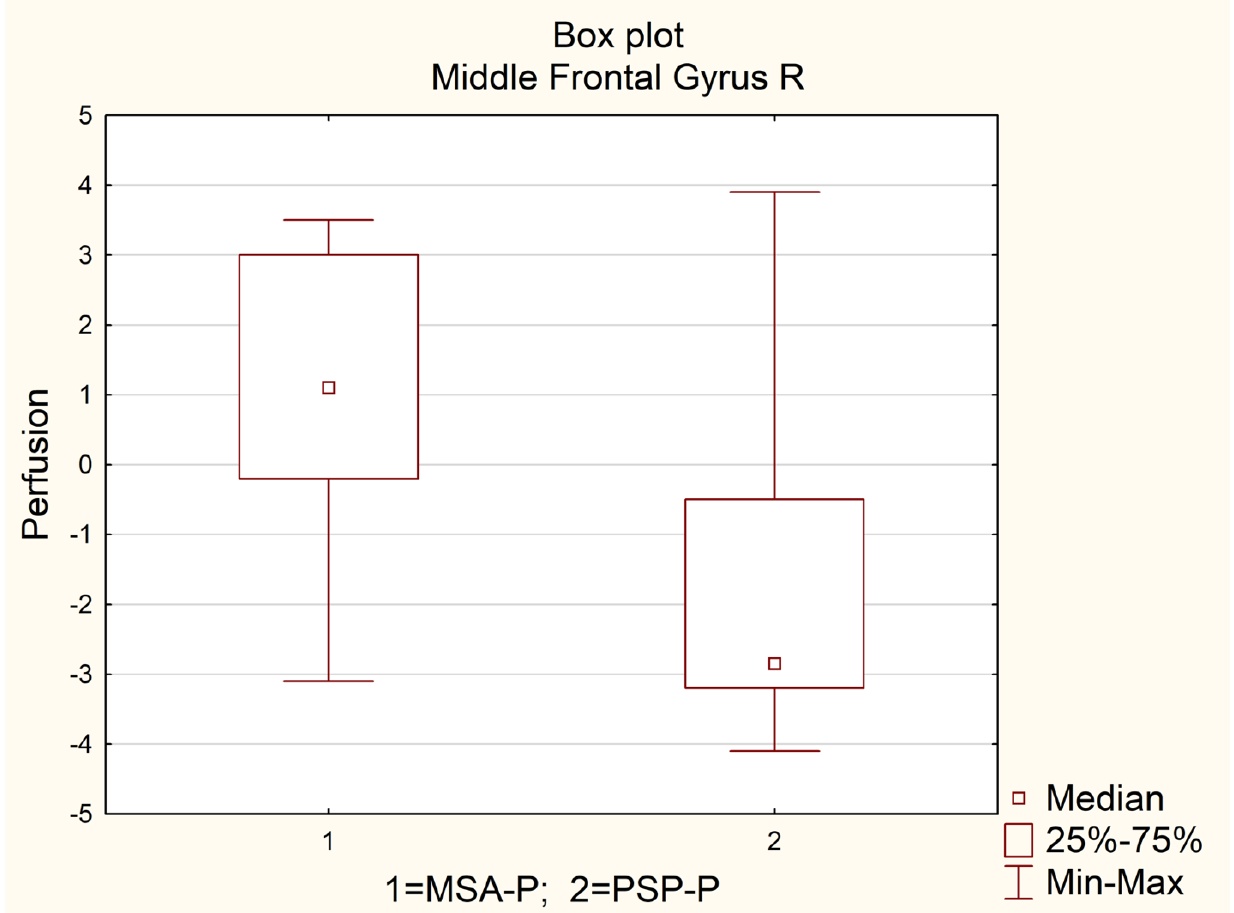
Figure 1. Box-plot presenting differences in the perfusion of PSP-P and MSA-P.